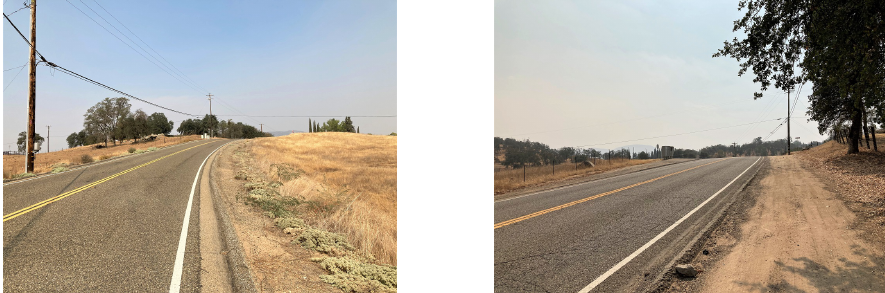
Figure 4. Example rural intersection from the point of view of vehicles traveling north–south through the intersection. Note the lack of visibility across the intersection.